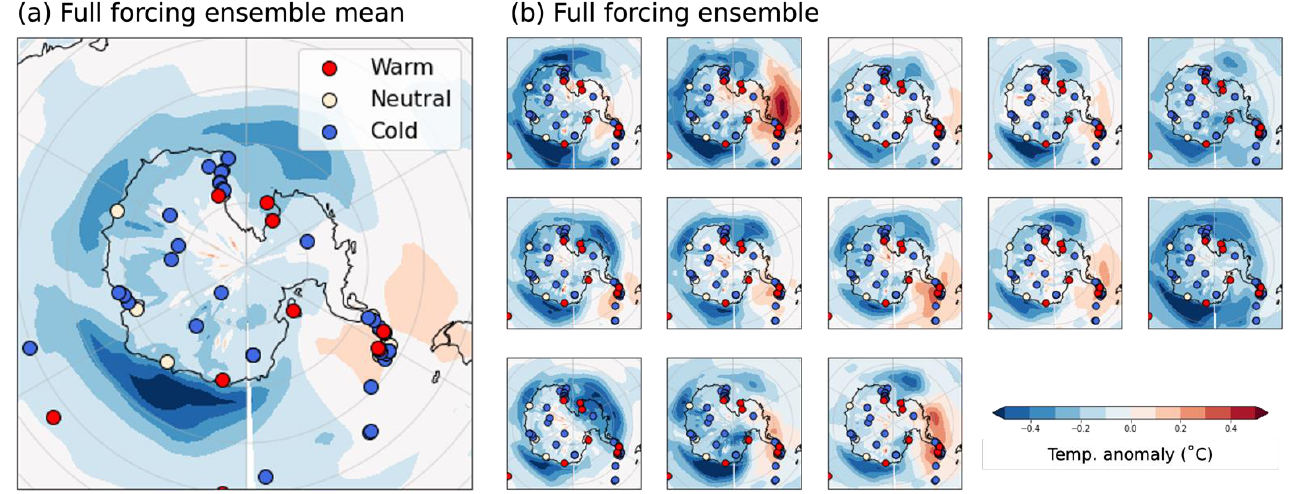
Figure 8. LM surface temperature anomaly (1500 – 1850 CE relative to 950 – 1250 CE) in the LME full forcing ensemble mean ( a ) and individual ensemble members ( b ) compared to qualitatively assessed paleotemperature records assembled in Lüning et al. [13]. A full list of paleoclimate records and the LM temperature trend is included in Table S1.